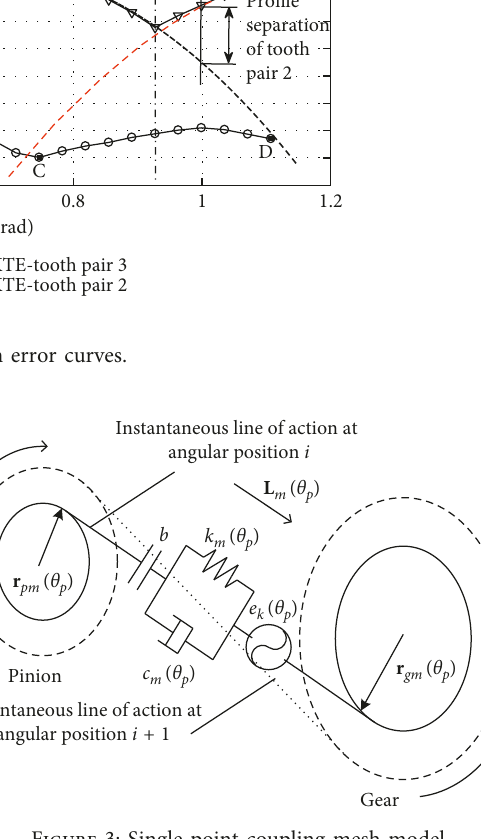
Figure 3: Single-point coupling mesh